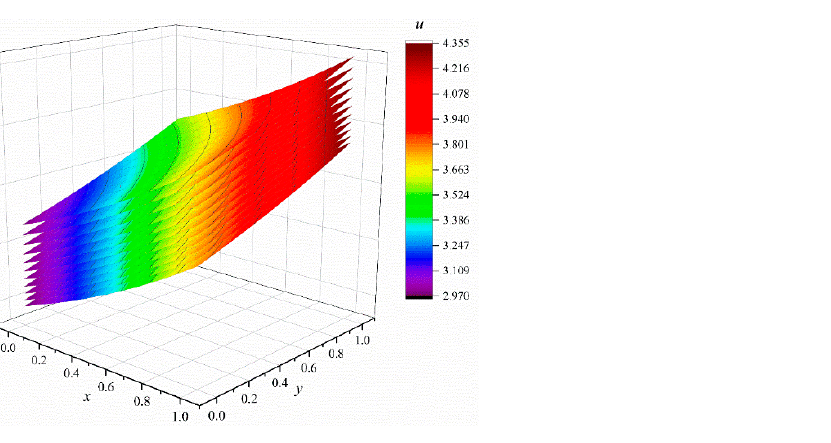
19 of 23 Figure 10. Calculation results along y -axis when t 0 is different.